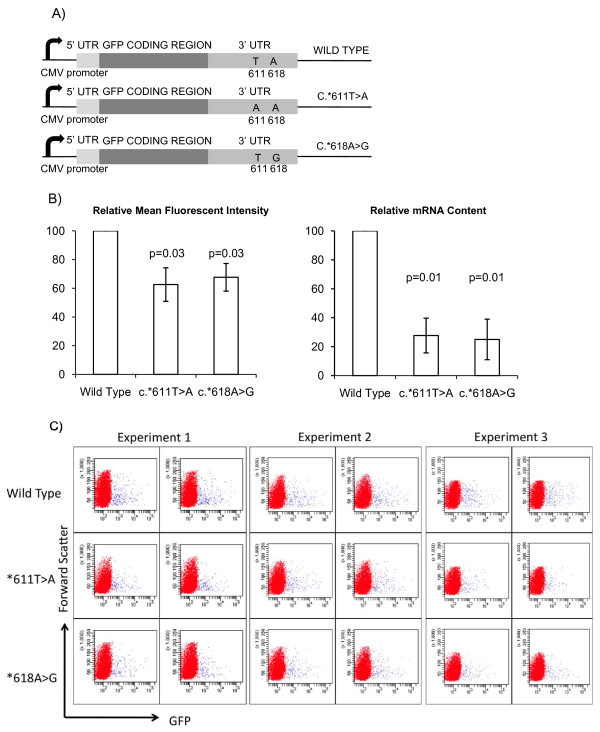
3'UTR plasmid reporter assay. A) Schematic diagram of pTH-GFPa constructs used in mRNA translational efficiency assays. B) 3'UTR plasmid reporter system and FACS analysis (n = 3, duplicate wells analysed in each experiment, 2-tailed t-test, error bars SD); (i) Mean fluorescence intensity (MFI) of RT112 cells transfected with GFP-flanked by mutant 3'UTR sequences relative to that of GFP-flanked by wild-type XPC UTR sequences; (ii) Relative levels of GFP mRNA to 36B4 mRNA analysed by quantitative RT-PCR using the ΔΔCt method. C) Flow cytometry data of individual transfections (n = 3, duplicate wells analysed in each experiment). GFP fluorescence measured on × axis (forward scatter on y axis). See Table 3 for mean fluorescent intensity values.